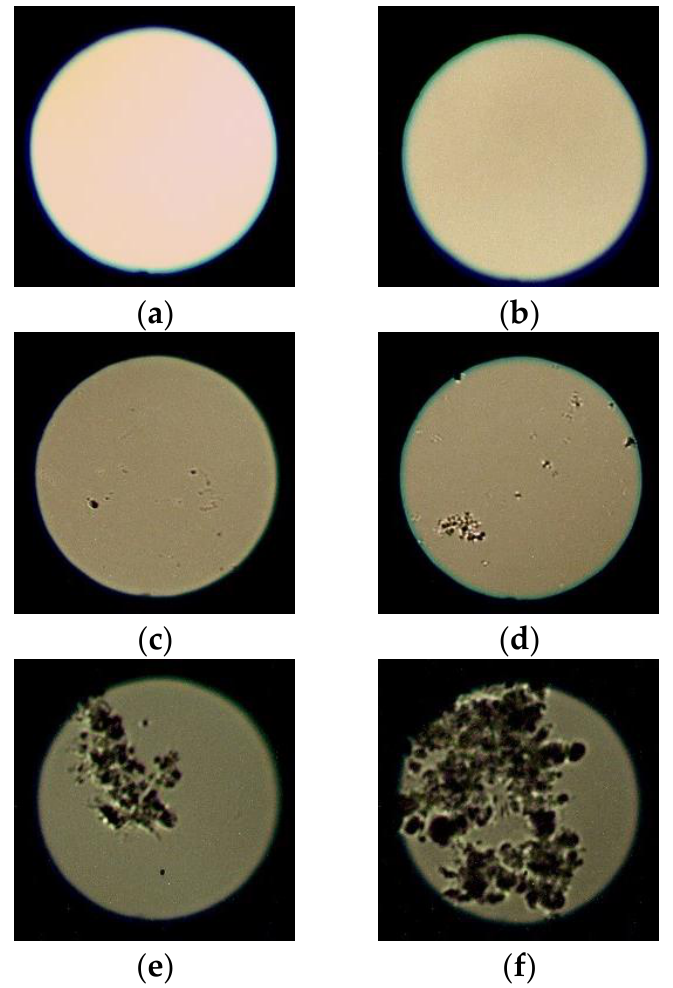
Figure 1. Optical images of ( a ) mineral oil, ( b ) palm oil, ( c ) mineral oil with 0.02 g/L CNT, ( d ) mineral oil with 0.03 g/L CNT ( e ) palm oil with 0.02 g/L CNT, ( f ) palm oil with 0.03 g/L CNT.